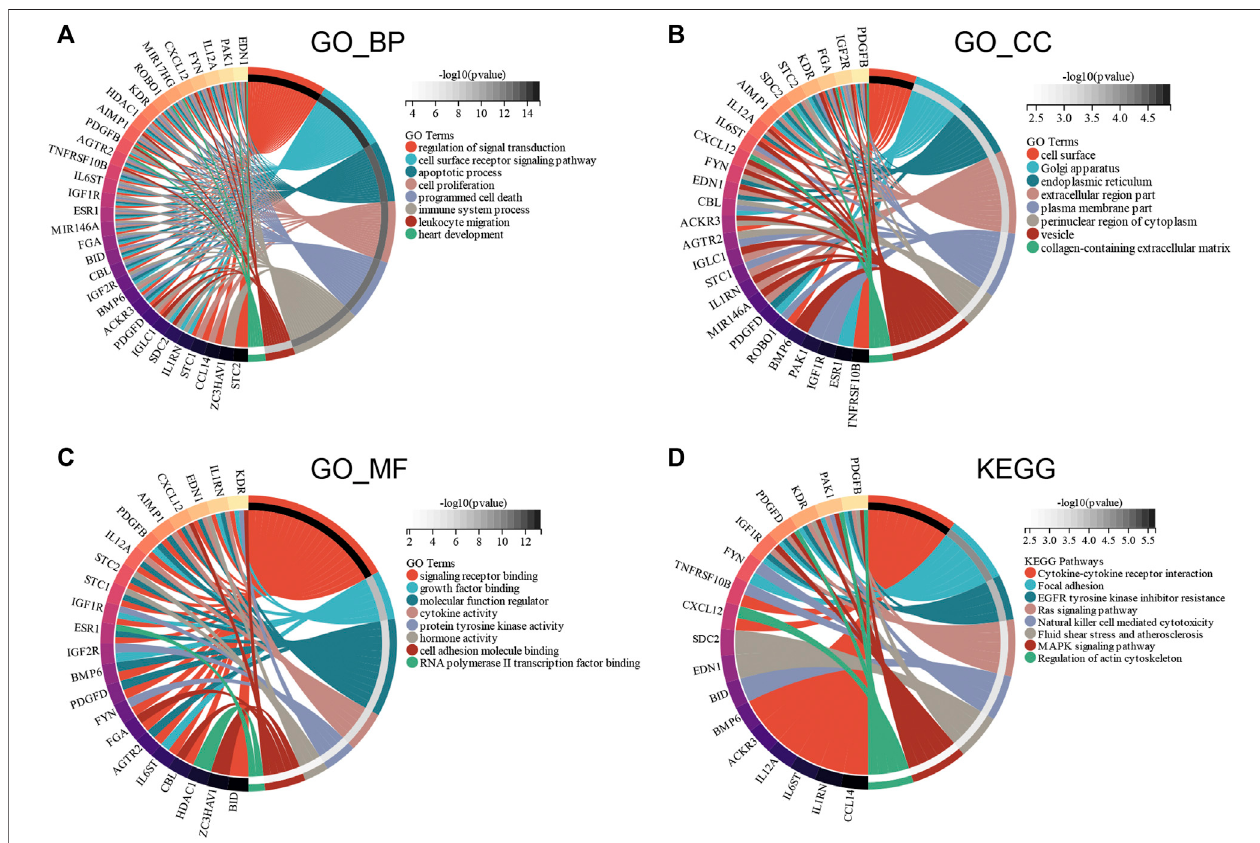
FIGURE7| FunctionalenrichmentanalysisofceRNANetwork. (A) biologicalprocess, (B) molecularfunction, (C) cellcompositionand (D) KEGGanalysisresultsof differentially expressed immune-related genes between male and female.